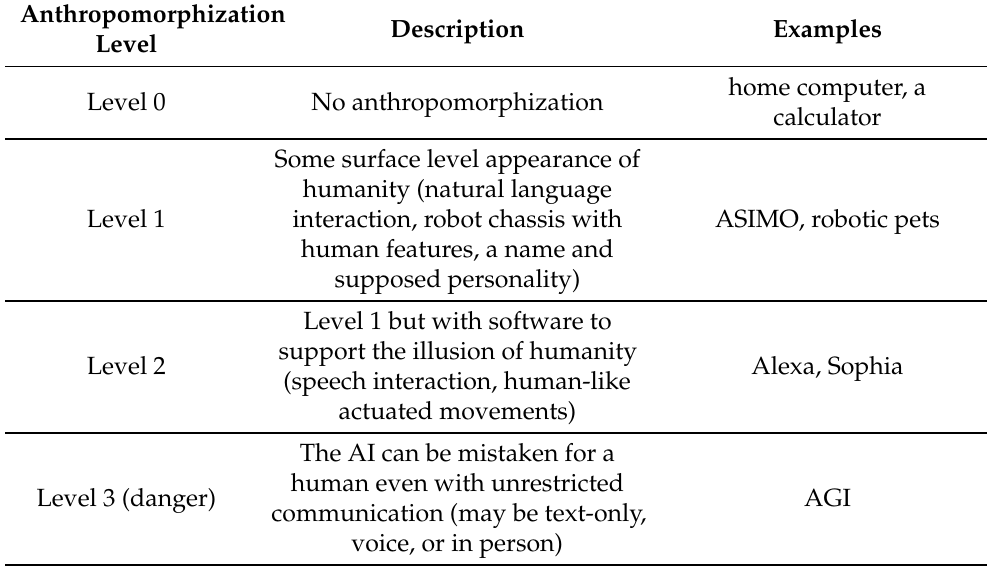
Table 8. AI anthropomorphization levels with